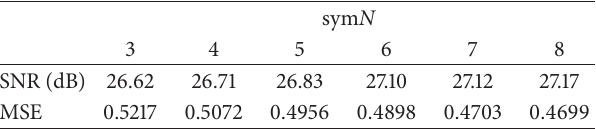
Table 7: The SNR and MSE results of rotation speed with different wavelet functions of sym N .